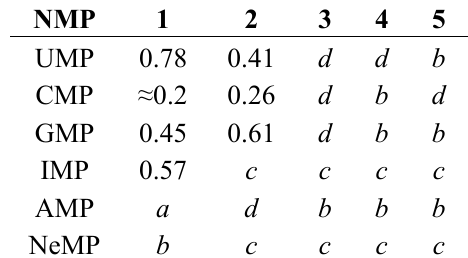
Table 3. Mole fraction of NMPs engaged in a mixed-ligand Pd 2+ complex with modified nucleosides 1 – 5 , when the total concentration of 1 , K 2 PdCl 4 and NMP is 4.0, 4.0 and 5.0 mmol·L − 1 ,